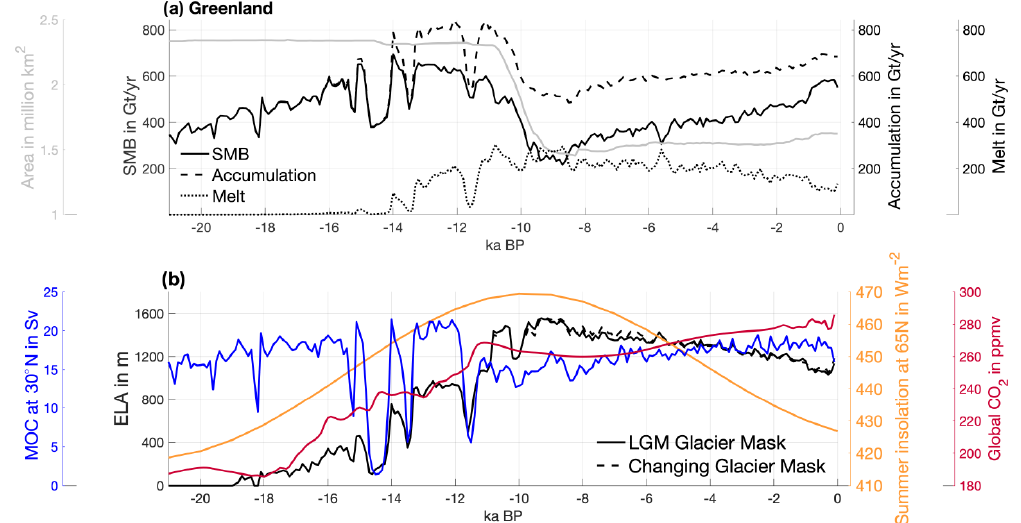
Figure 3. (a) Greenland SMB, accumulation, melt, and ice-sheet area and (b) equilibrium line altitude (ELA) and meridional overturning circulation (MOC) for the EBM MPI-ESM-CR experiment, together with summer insolation at 65 ◦ N and CO 2 concentration throughout the last deglaciation (21 to 0ka). Here, 0ka refers to the year 1950. SMB, accumulation, melt, and ELA (dashed) are integrated over the glacial mask of each individual 100-year time slice. Additionally, the ELA (solid) is integrated over the constant 21ka ice-sheet mask in order to investigate differences due to the ice-sheet mask. The MOC is the overturning strength at 30.5 ◦ N at a depth of 1023m, as in Klockmann et al. (2016). The CO 2 concentration is taken from Köhler et al. (2017) and the summer insolation from Berger and Loutre